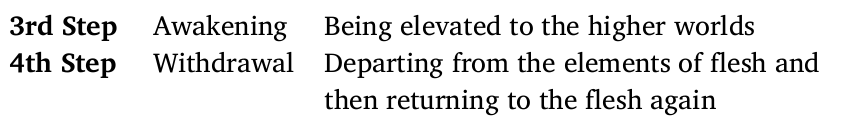
Table 5 Āẕar Kaivān’s mystical four steps in Ğām-e Kai Ḫosro .